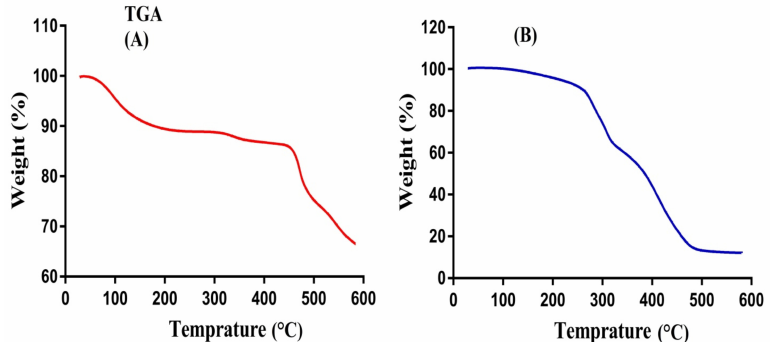
Figure 3. Thermogravimetric Analysis (TGA) of ( A ) SPS, ( B ) SPSPAA hydrogel.